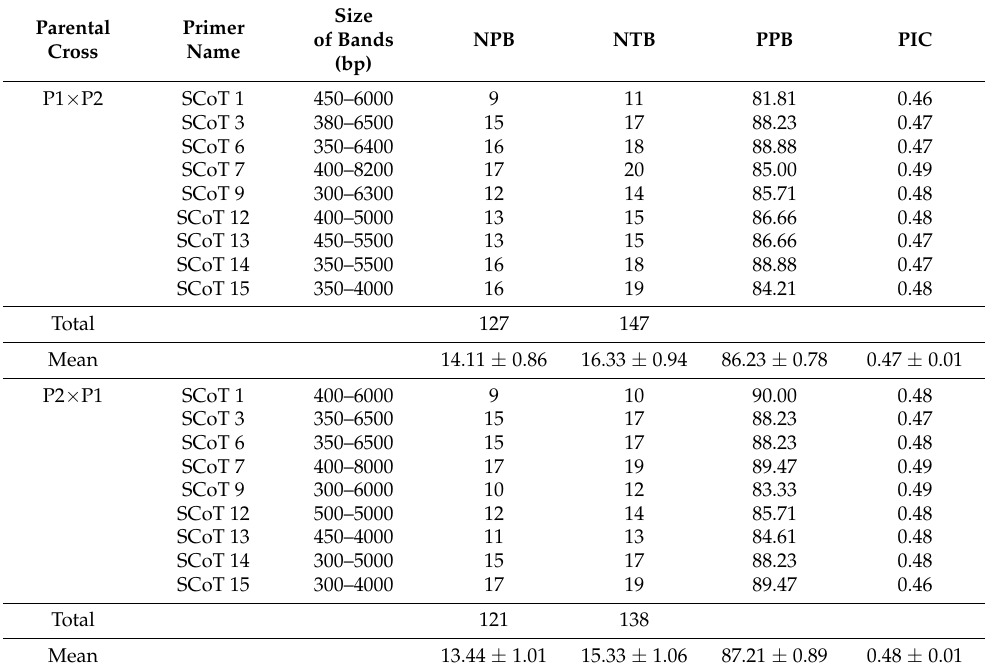
Table 3. The level of polymorphism detected with SCoT primers in Streptocarpus parents and F 1 progeny from reciprocal